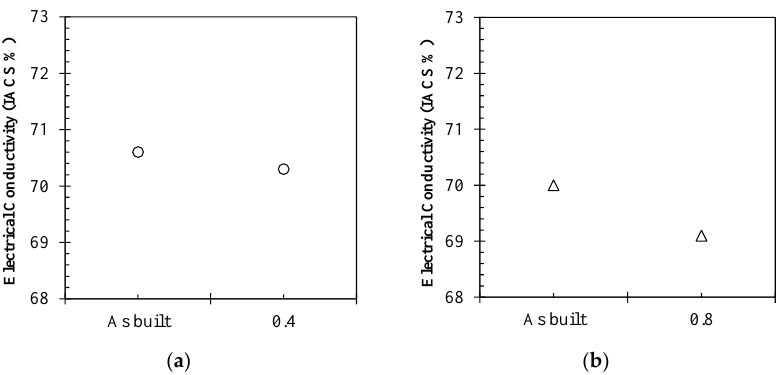
Figure 12. Electrical conductivity performance of ( a ) sample 2.1 as built and following 0.4 a/cm 2 current density electropolishing regime and ( b ) sample 2.2 as built and following 0.8 a/cm 2 current density electropolishing regime.